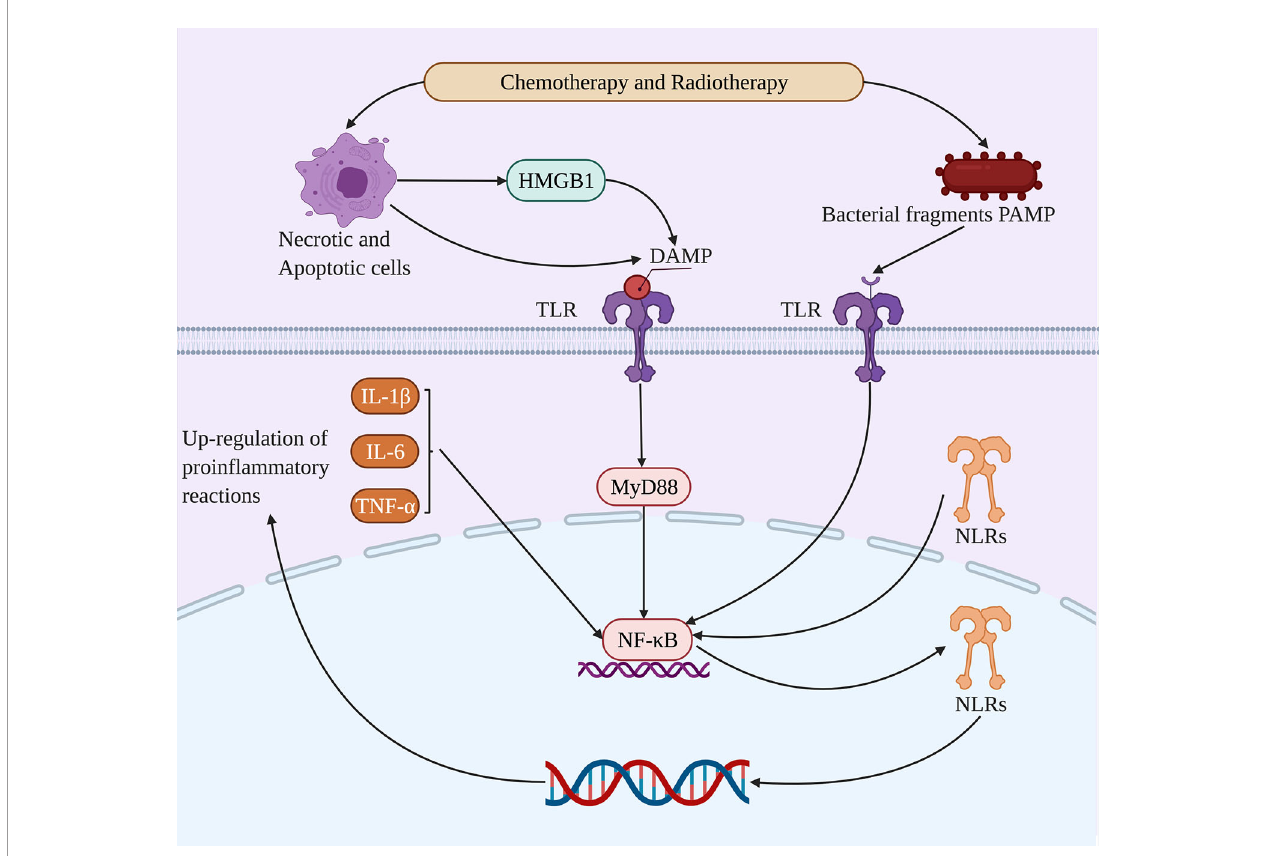
FIGURE 1 | Microbial dysbiosis alters molecular pathways in RIOM/CIOM. Chemotherapy and radiotherapy lead to microbiota dysbiosis, after which TLRs can bind to HMGB1 as DAMPs from necrotic and apoptotic cells, as well as bacterial fragment PAMPs. Thus, TLRs upregulate NF- k B through the MyD88 signaling pathway and activate NLRs and proin fl ammatory reactions including IL-1 b , IL-6, and TNF- a , promoting the damage of nucleic acids and the positive feedback of proin fl ammatory reactions to participate in